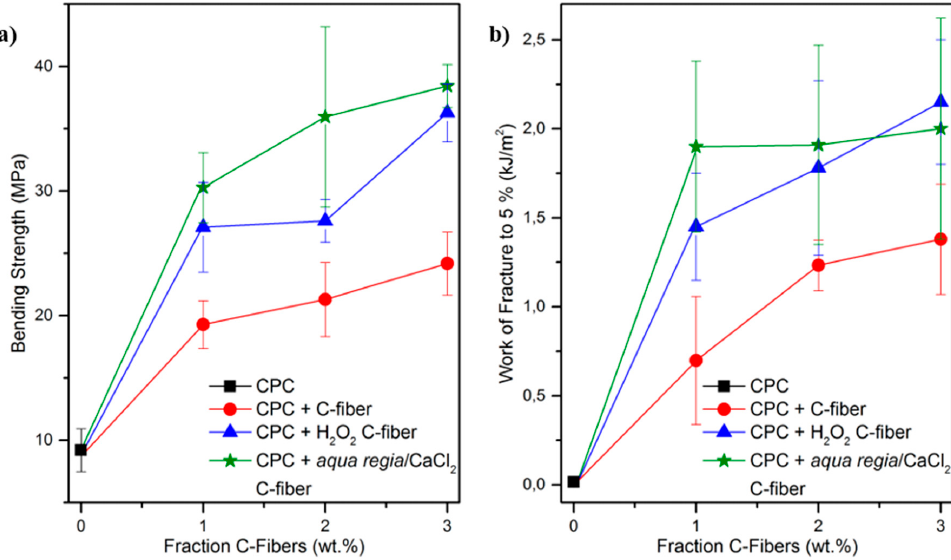
Figure 4. ( a ) Bending strength and ( b ) work of fracture up to 5% strain of C-fiber reinforced calcium phosphate cement (CPC) depending on the fiber fraction for different chemical fiber surface modifications.